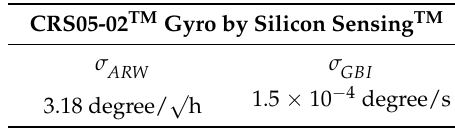
and gyro bias instability σ ARW